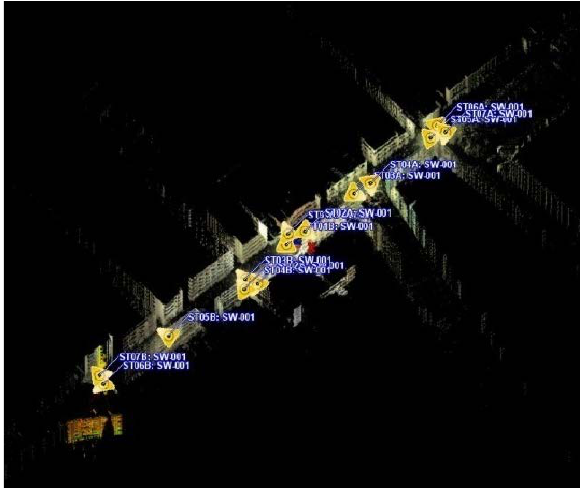
Figure 1. The DSM of Cosenza.